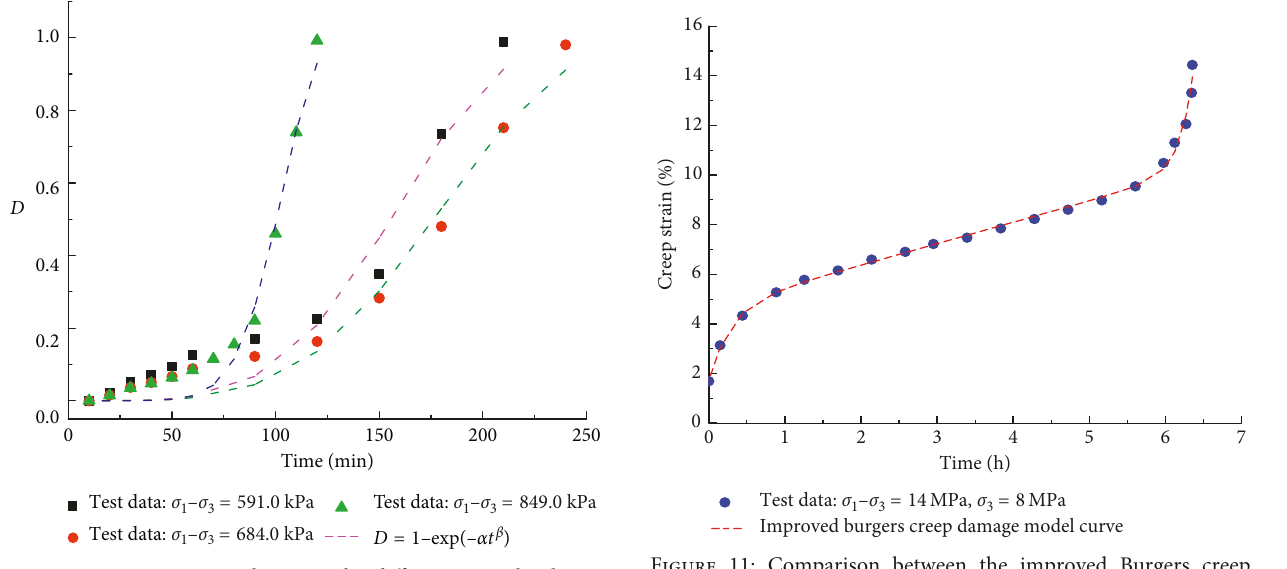
Figure 9: Damage evolution under different stress levels.